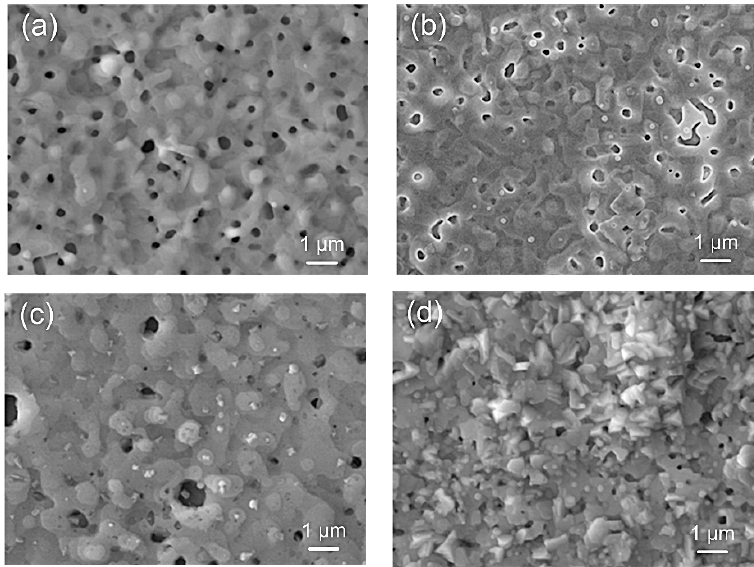
Figure 5. SEM morphologies of the top YBCO layers in YBCO/LAO/YBCO trilayer films with the samples of ( a ) SS, ( b ) SIS-20, ( c ) SIS-40, and ( d ) SIS-70.